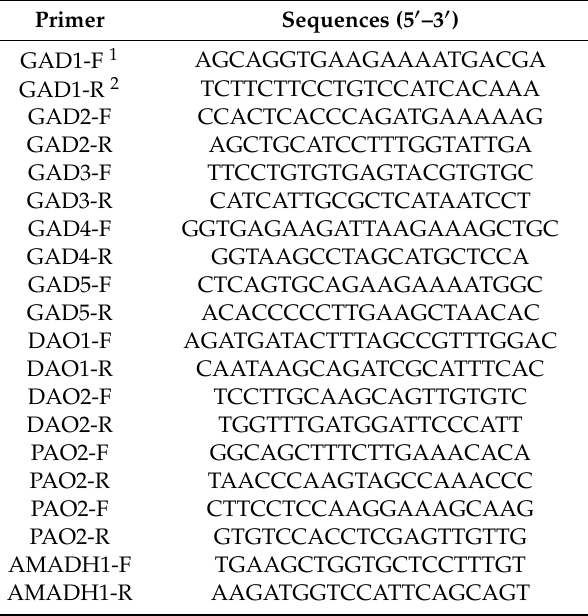
Table 1. Sequence-specific primer used for quantitative real-time (qRT)-PCR assay in germinating soybean. Primer Sequences (5 (cid:48) –3 (cid:48)